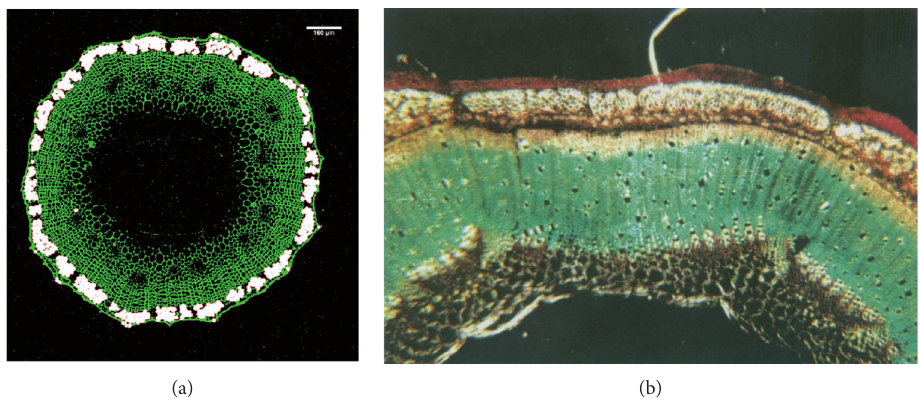
Figure 2: X-ray µ CT image and optical micrograph of flax and hemp stem, respectively [18,